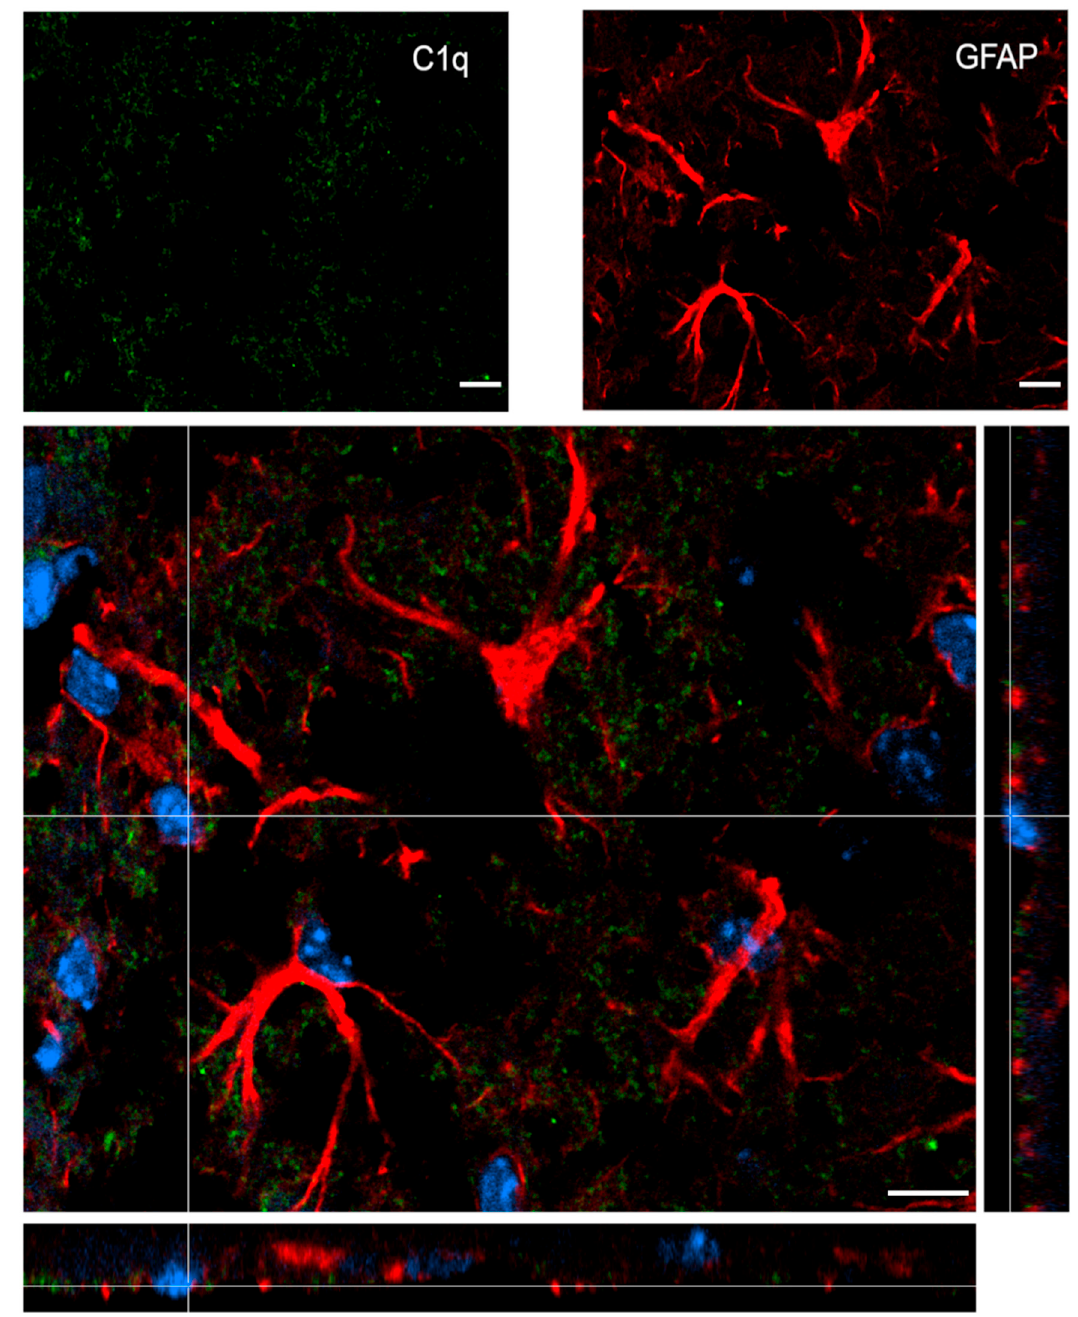
Figure 7. Confocal analysis of C1q and astrocyte reciprocal localization in the contused cortex 96 h after TBI. A high magnification image shows that C1q (green) does not specifically colocalize with astrocytes (GFAP, red). Nuclei are in blue. Images are representative of at least two independent experiments. Scale bar = 10 µ m. Figure 8 shows confocal analysis of C1q and neuronal localization in the contused cortex 96 h after TBI.